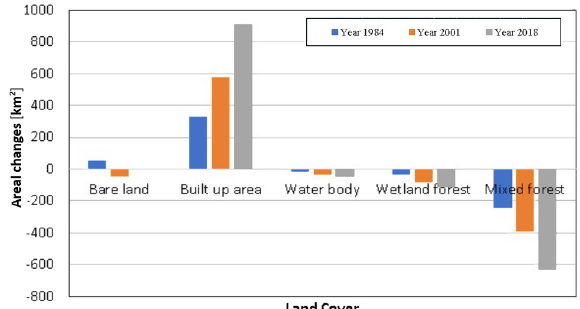
Fig. 3. Changes in land cover during